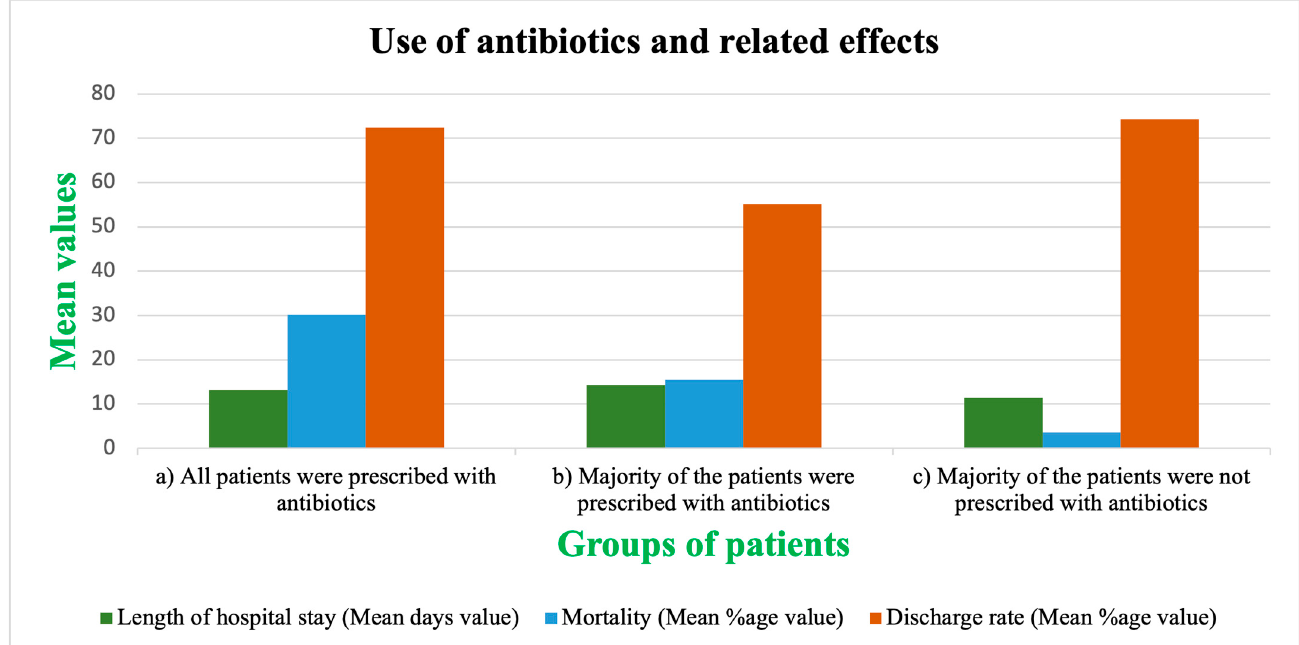
Figure 3. The use of antibiotics in COVID-19 patients divided into three groups ( a ) all patients using antibiotics, ( b ) the majority of the patients using antibiotics, and ( c ) the majority of the patients not using antibiotics) and related effects (length of hospital stay, mortality, and discharge rate).